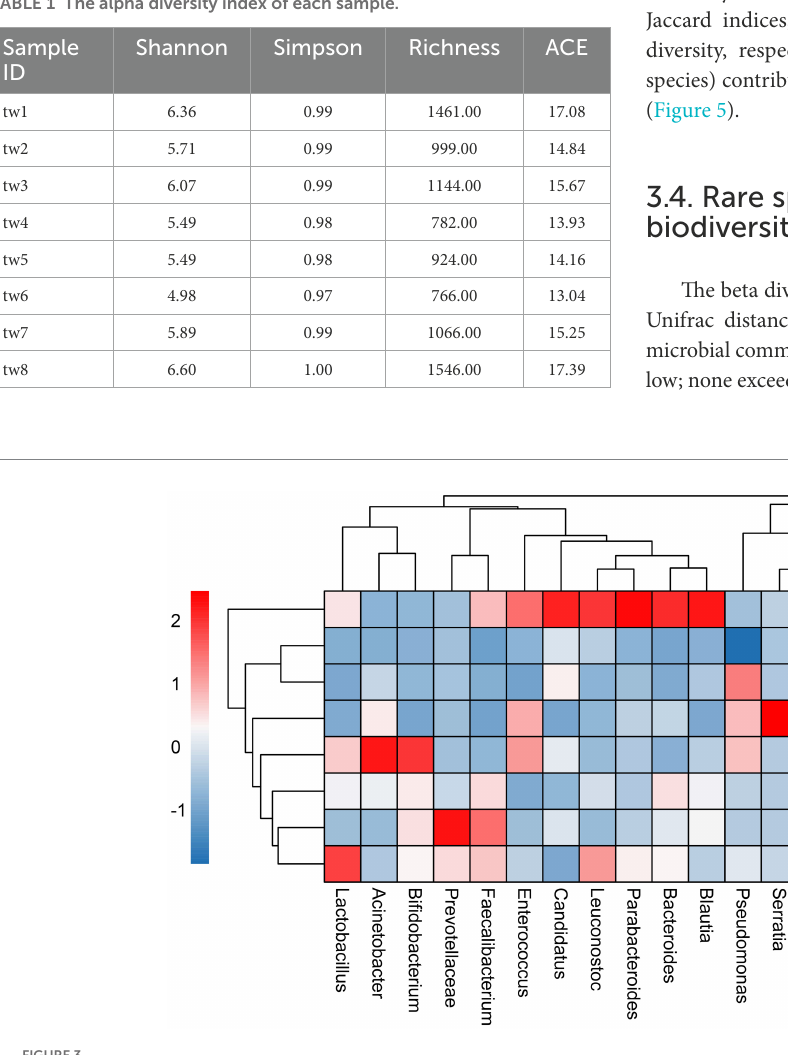
FIGURE 3 Heat map of relative abundance clustering of dominant genera. The tree diagram is obtained based on similarity clustering. The sample ids for the filter paper are tw1 through